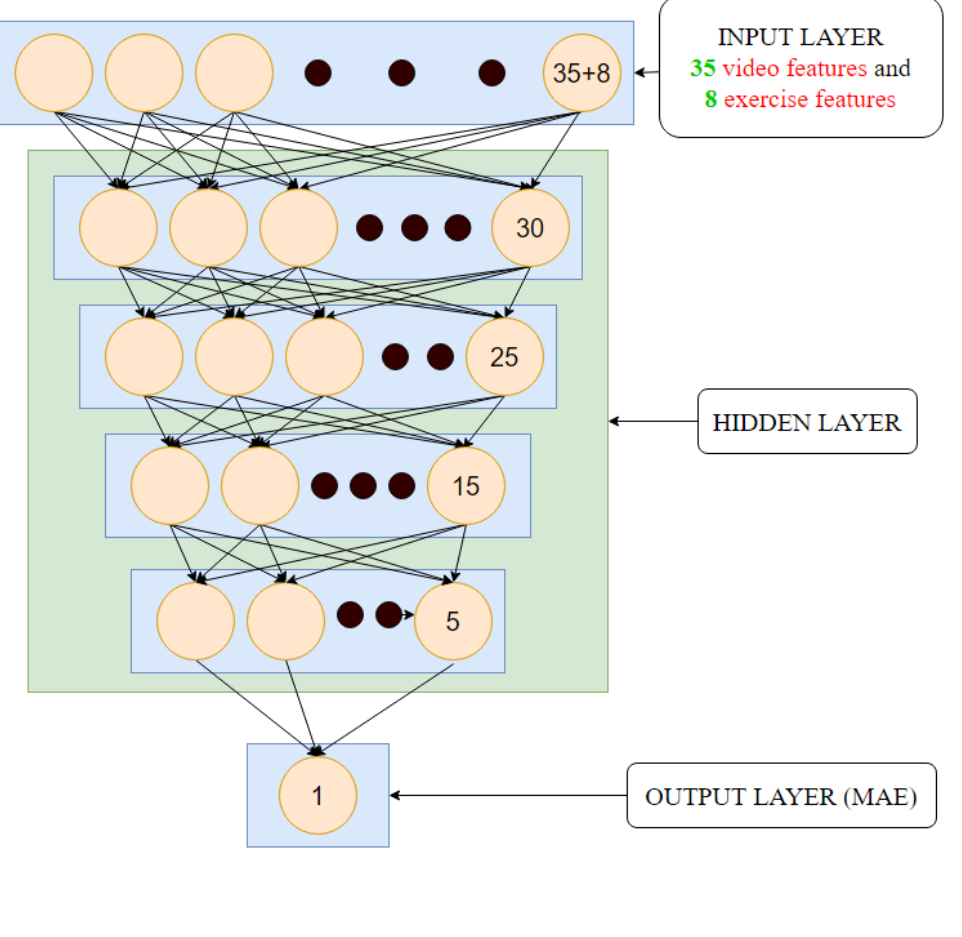
Figure 1 Architecture of Satisfaction Score Prediction Model Based on Learning